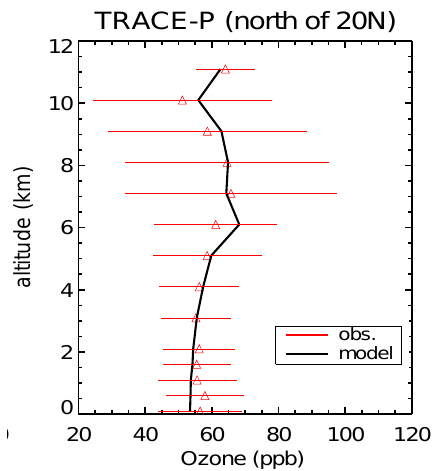
Fig. 3. Ozone profile observed north of 20 ◦ N during the TRACE- P aircraft mission and model results. Observations are shown in red triangles and the model results as black line. Both model and observations are for the year